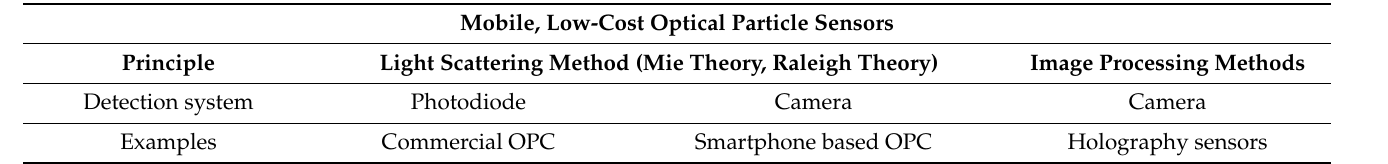
Table 2. Two main categories of low-cost mobile optical particle detection